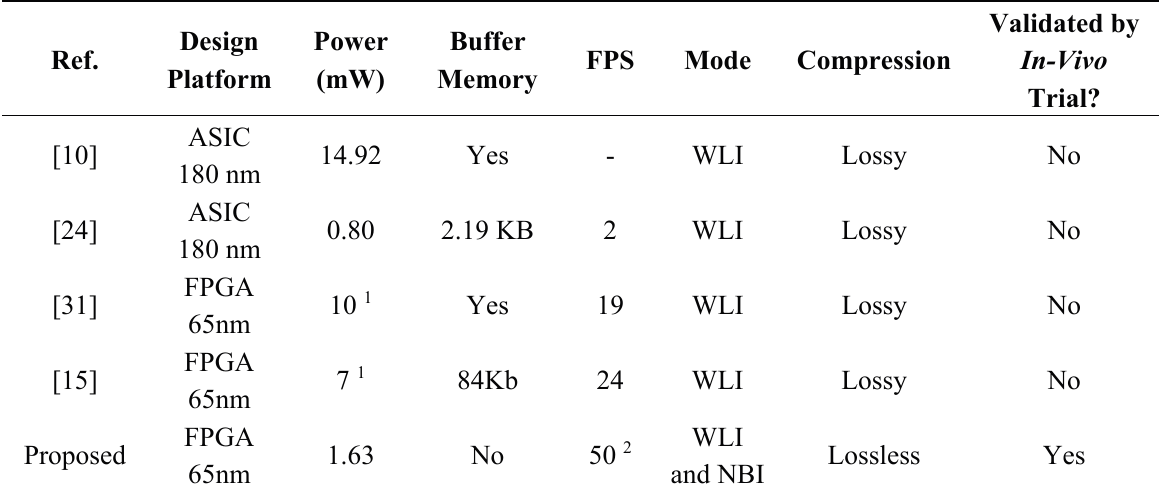
Table 9. Comparison of compressor with other